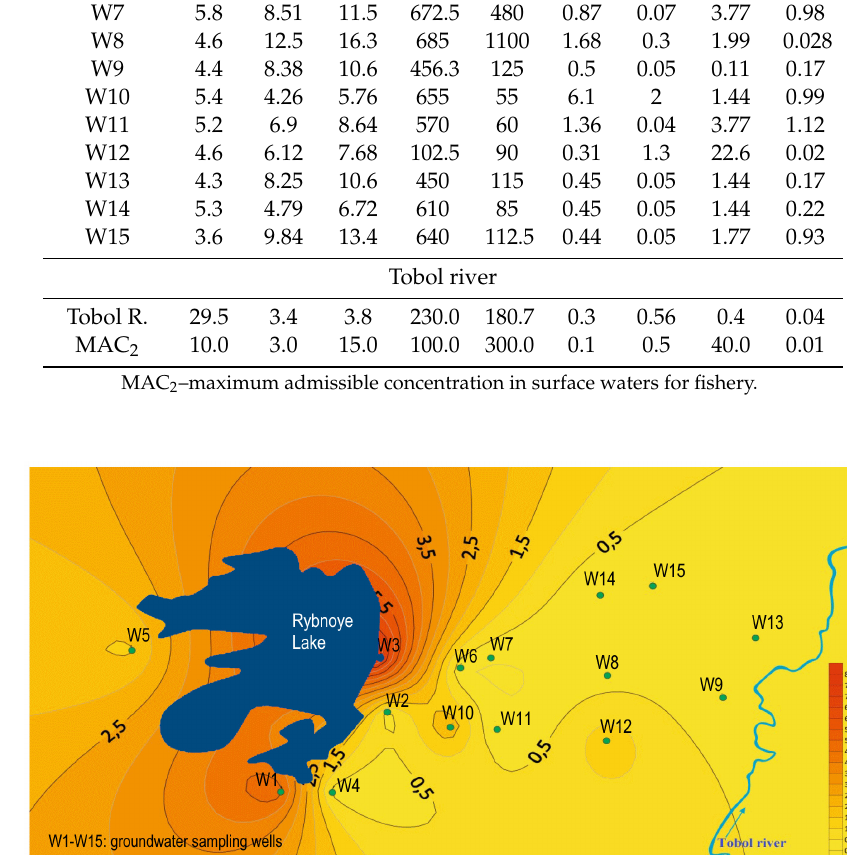
Figure 3. Isolines of groundwater level (m a.s.l.) in the study area.